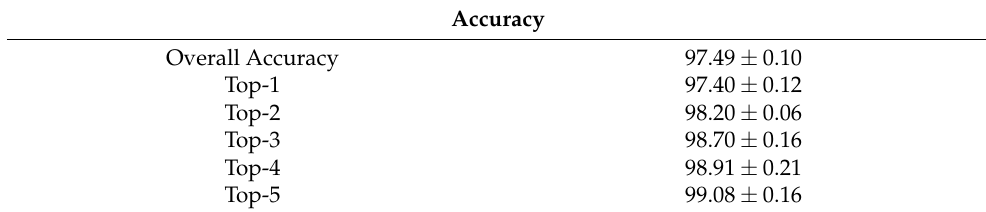
Table 4. The accuracy of the proposed system on the second